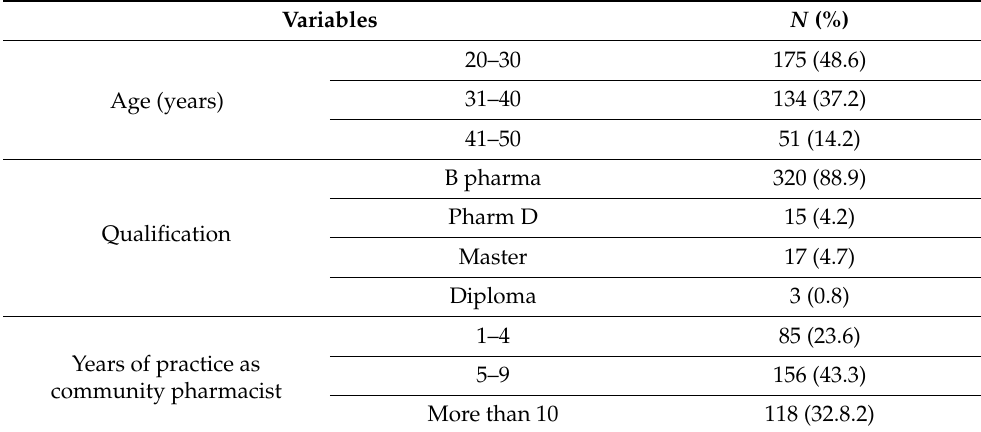
Table 1. Demographics of participating pharmacists in the survey ( n = 360 *).